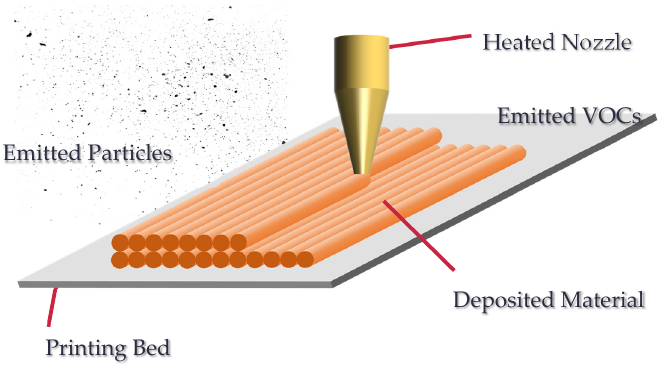
Figure 1. Airborne emissions in FFF 3D printing.